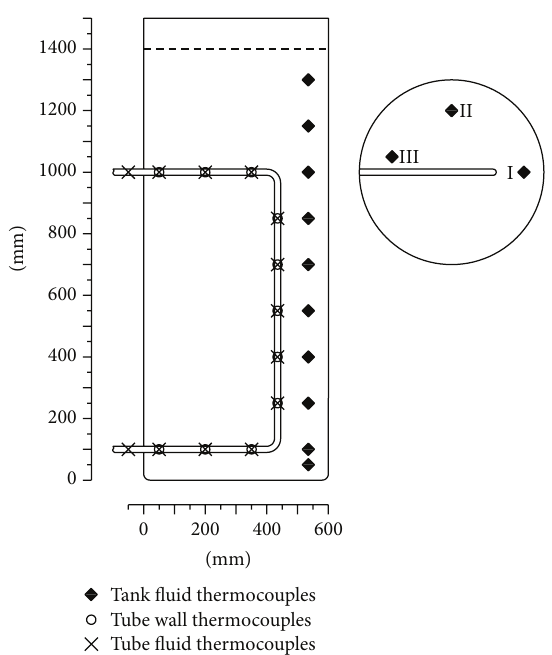
Figure 2: Water tank and thermocouple